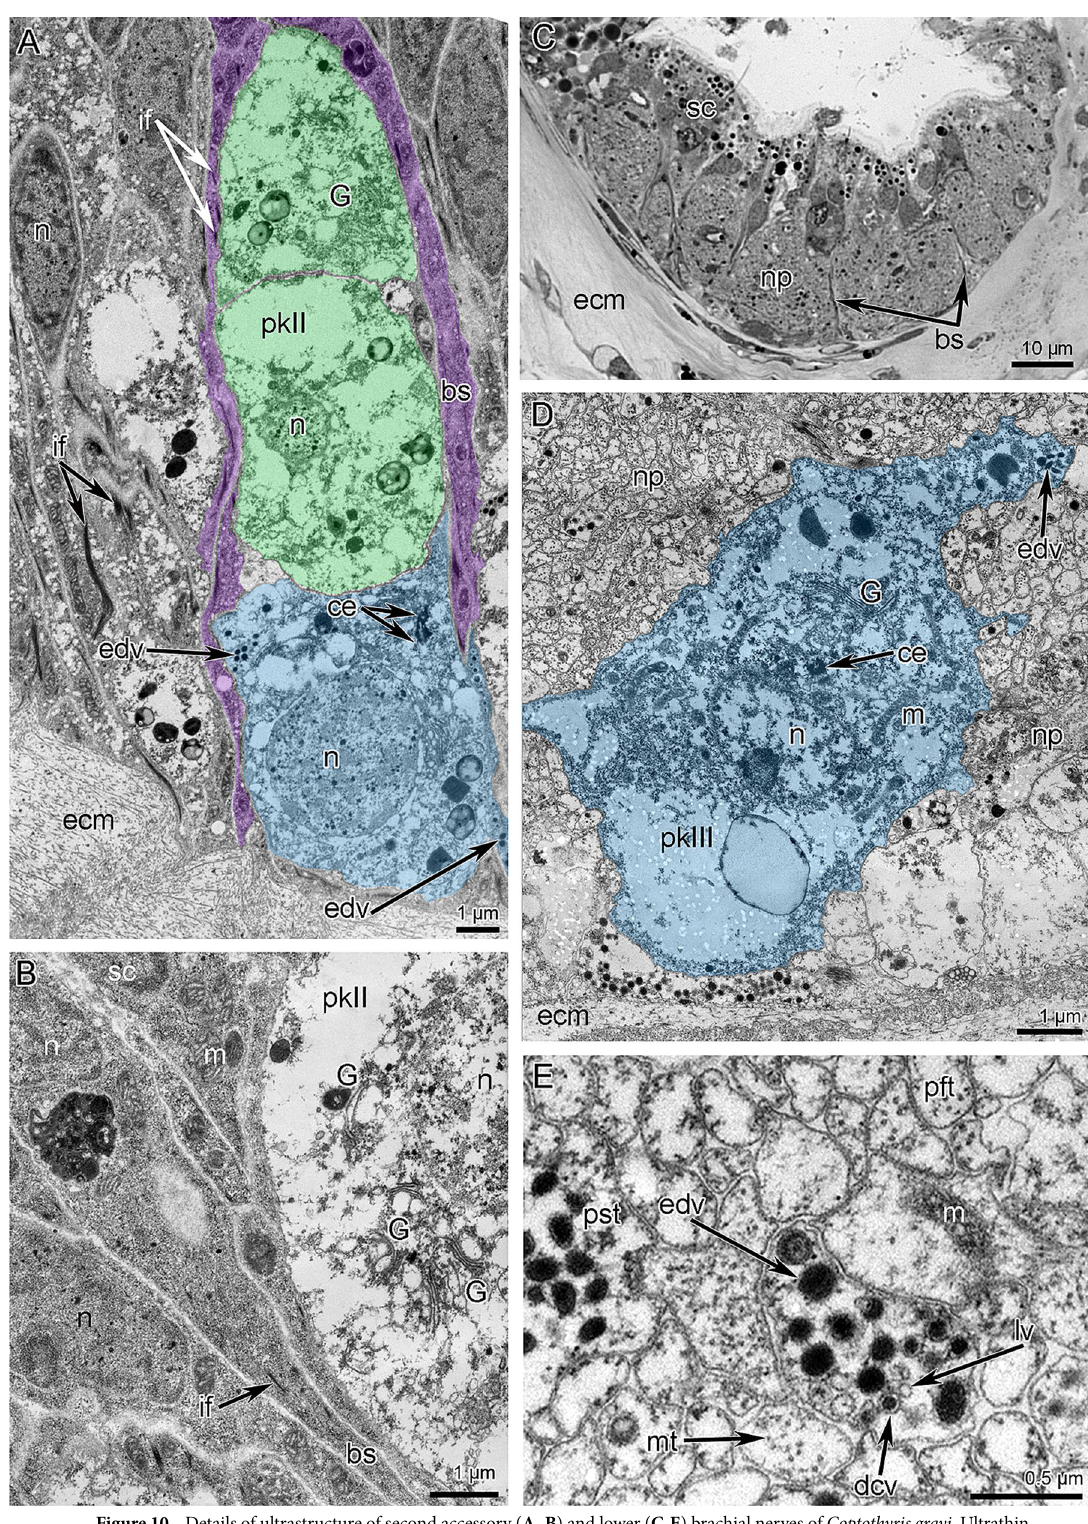
Figure 10. Details of ultrastructure of second accessory ( A – B ) and lower ( C-E ) brachial nerves of Coptothyris grayi . Ultrathin ( A – B , D – E ) and semithin ( C ) sections. ( A ) A portion of second accessory brachial nerve with perikarya of second type (green) and perikaryon of third type (blue), which are covered by basal projections of supportive cells (magenta). ( B ) A portion of perikaryon of second type: many Golgi apparatuses are visible. ( C ) General view of the lower brachial nerve: large cluster of neurites is crossed by long basal projections of supportive cells (= cells of radial glia). ( D ) A portion of lower nerve with the perikaryoin of third type (blue). ( E ) A portion of cluster of neurites: projections of different types are visible. Abbreviations: bs—basal projection of supportive cells; ce—centriole; dcv—dense-core vesicle; ecm—extracellular matrix; edv—vesicles with electron dense content; G—Golgi apparatus; if—intermediate filaments; lv—synaptic vesicles with electron-lucent content; m—mitochondria; mt—microtubules; n—nucleus, np— cluster of neurites; pft—projections of first type; pkII—perikarya of second type; pkIII—perikarya of third type; pst—projections of second type; sc—supportive cells (= cells of radial